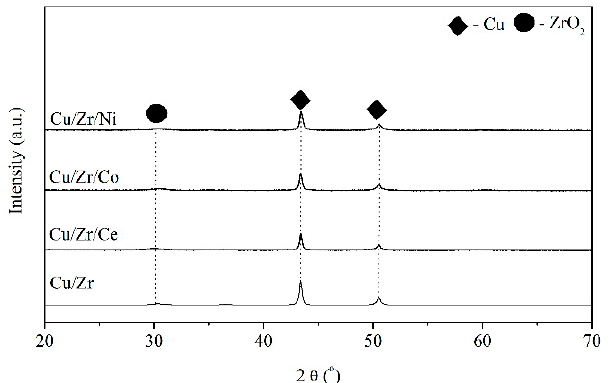
Figure 1. XRD patterns of tested catalysts after hydrogen reduction.